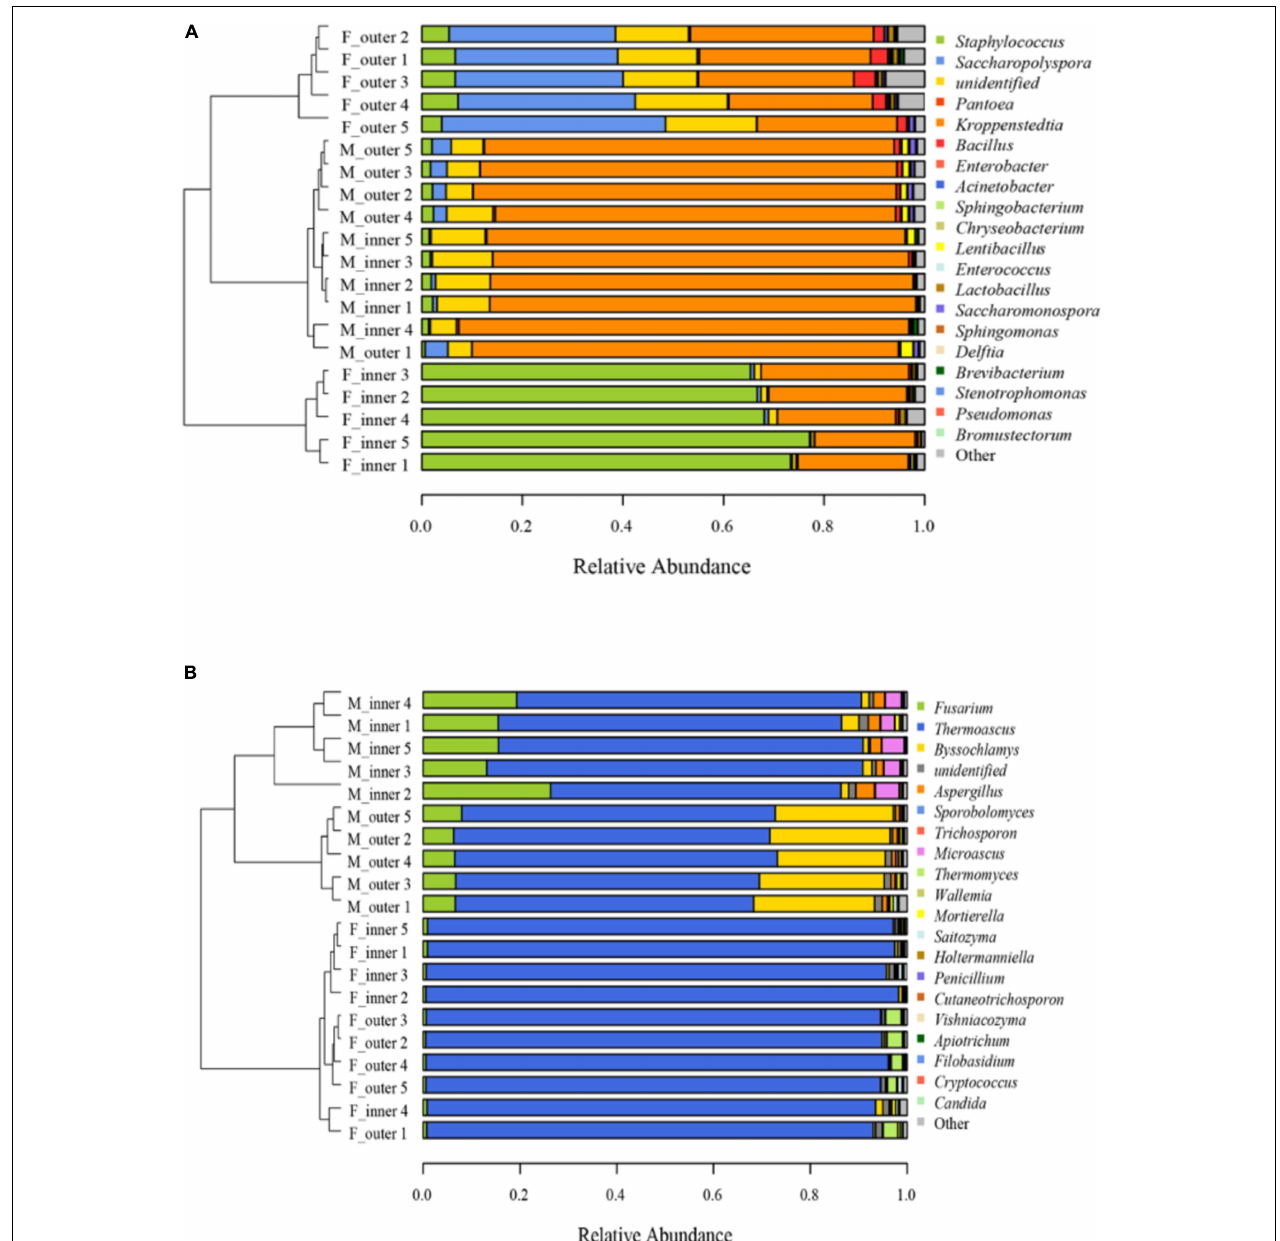
FIGURE 1 | Microbial communities of Daqu samples (A) Bacterial community. (B) Fungal community. F-inner: Inner of fresh Daqu ; F-outer: Outer of fresh Daqu ; M-inner: Inner of mature Daqu ; M-outer: Outer of mature Daqu . Cluster analysis was based on Unweighted UniFrac distance matrix and the UPGMA method. Genus level ( n =